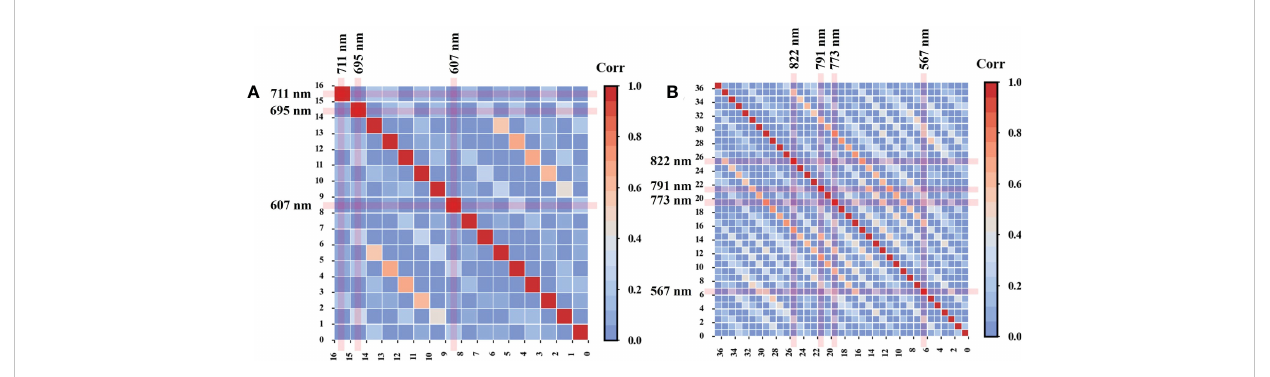
TABLE 3 Classi fi cation results of tomato plant DS based on spectroscopy-image combination.